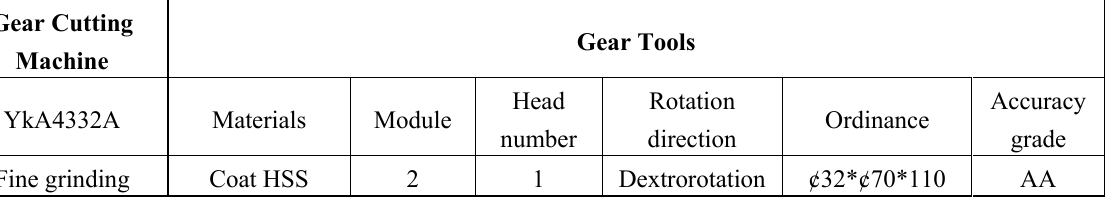
Table 9. Machine tool and cutting fluid for the gear